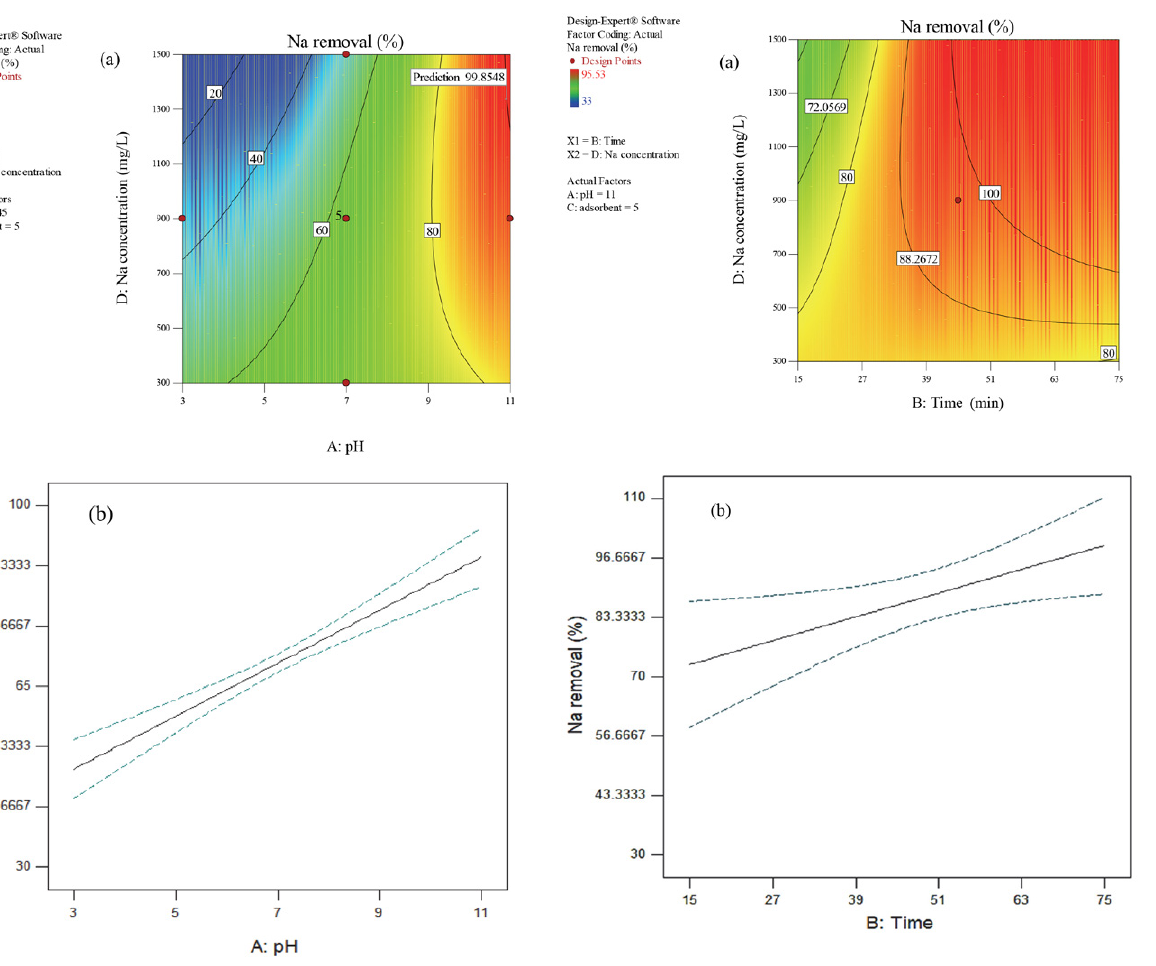
Figure 4 . The effect of pH on the sodium ion adsorption from an aqueous solution using the AC in different concentrations of sodi- um